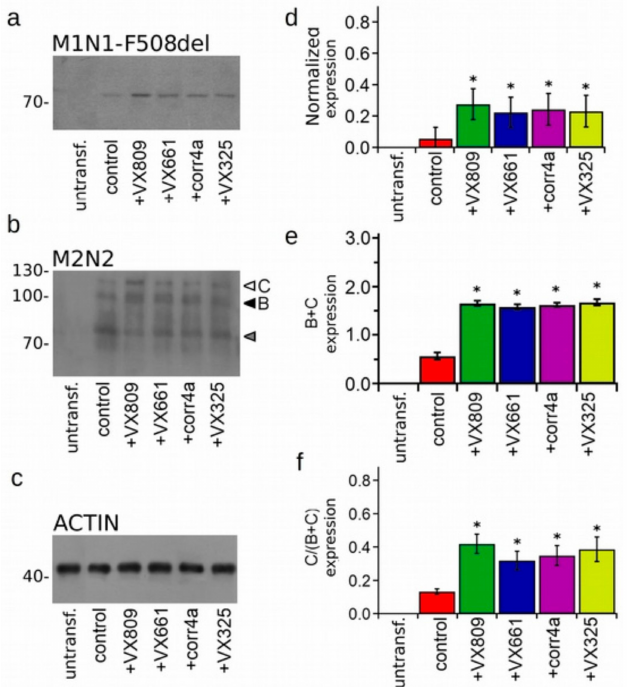
Figure 5. Expression of the F508del-CFTR N-half co-expressed with the C-half. (A) Detection of M1N1-F508del ( a ) and M2N2 ( b ) in whole cell lysates of untransfected (untransf.) and transiently co-transfectedHEK-tcellstreatedwithDMSO(control), VX809, VX661, corr4aandVX325. ( c ) Expression of the protein actin in the same samples in ( a ) and in ( b ). The molecular weights of the proteins of the molecular weight marker that was run in the SDS-PAGE are shown on the left of each blot. ( d ) Normalized expression of the F508del-M1N1 polypeptide. ( e ) Bar graph indicating the quantification of the total M2N2 protein expression, calculated as the sum of bands B and C, normalized by the actin expression. ( f ) Bar graph indicating the quantification of the mature, fully glycosylated fraction of the M2N2 protein, expressed as the C / (C + B) band ratio. Data are expressed as mean ± standard error of the mean (SEM) of at least four independent experiments. Asterisks indicate a statistical significance versus the control: * p <